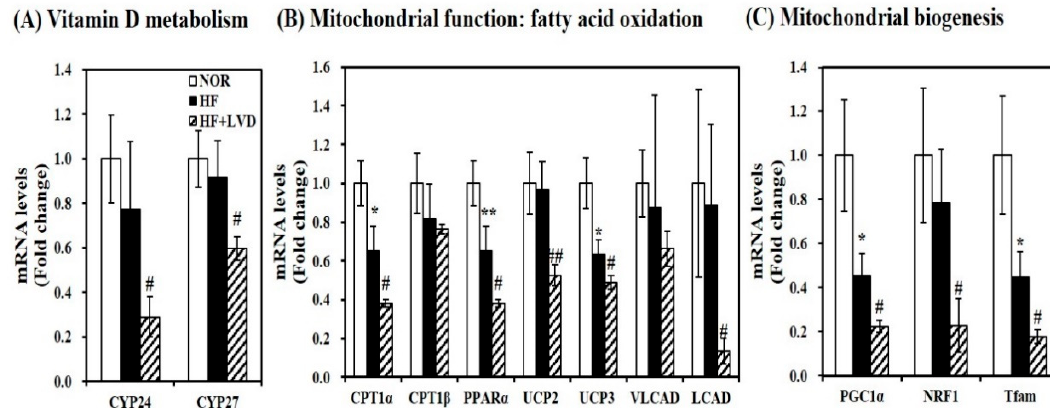
Figure 4. Vitamin D insufficiency decreases muscle mRNA levels related to vitamin D metabolism and mitochondrial biogenesis and function in HF-induced obese rats. mRNA levels were determined by qRT-PCR, normalized for all samples to β -actin, and expressed as the fold change compared to the NOR group. ( A ) vitamin D responsive genes; ( B ) mitochondrial function; ( C ) mitochondrial biogenesis). Results are expressed as mean ± SEM ( n = 7–9 per group). * p < 0.05; ** p < 0.01 compared to NOR. # p < 0.05; ## p < 0.01 compared to HF. NOR, 10% fat diet with 1000 IU vitamin D; HF, 45% fat diet with 1000 IU vitamin D; HF + LVD, 45% fat diet containing 25 IU vitamin D.